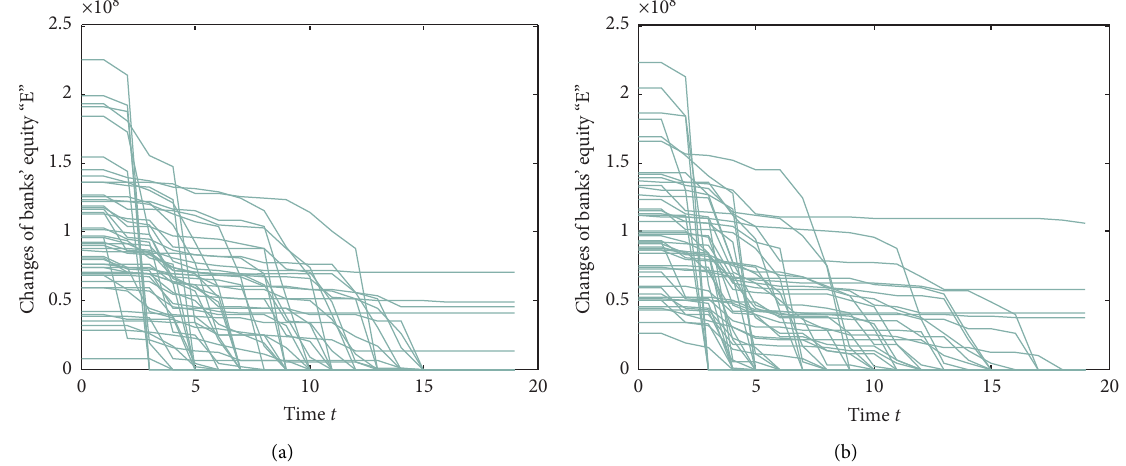
Figure 6: Changes of proportion of banks’ equity over time under different liquidity rates.